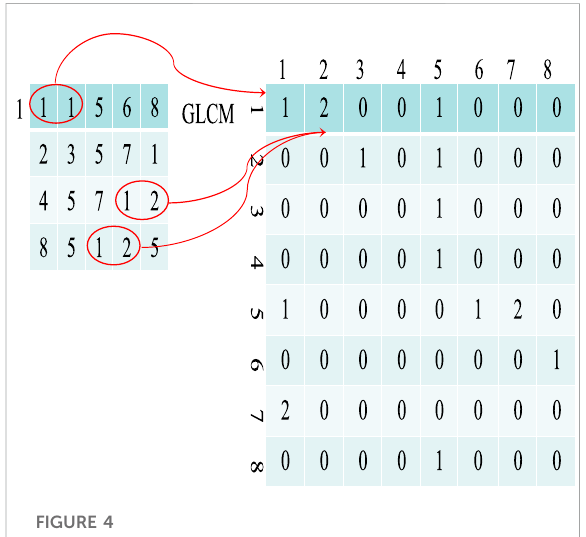
FIGURE 4 Calculation of the GLCM from a grayscale image (distance = 1, orientations = 0 °